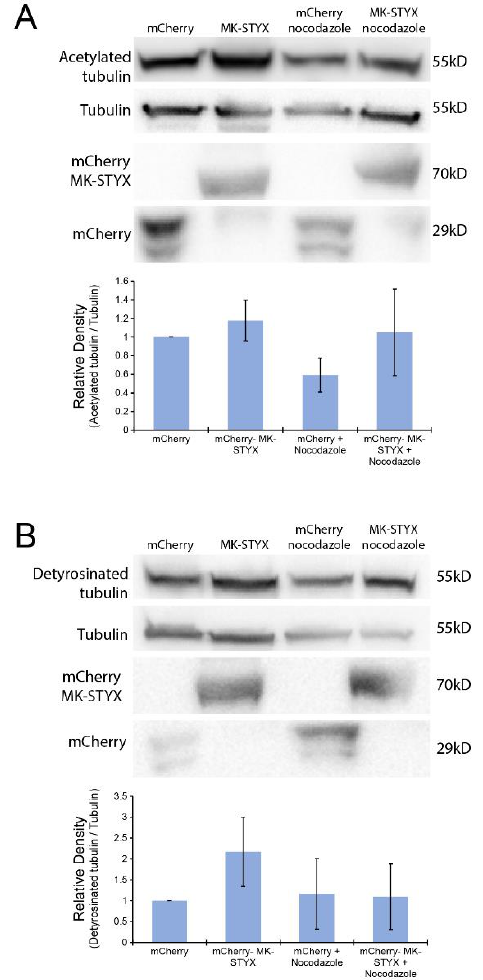
Figure 5. MK-STYX increases acetylated and detyrosinated tubulin. Cells were transfected with expression plasmids for mCherry or mCherry-MK-STYX. Twenty-four hours post-transfection, cells treated with nocodazole or not were lysed and analyzed by immunoblotting. We examined cells expressing mCherry constructs by fluorescence microscopy to confirm transfection. ( A ) Blots were probed with anti-acetylated tubulin and showed that acetylated tubulin (55 kDa) is significantly decreased (paired t -test; p < 0.05) in the presence of nocodazole in control cells (mCherry-expressing) relative to cells expressing mCherry-MK-STYX. Cells overexpressing MK-STYX sustain acetylated tubulin in the presence of nocodazole. The blots were stripped and probed for tubulin as the loading control; they were also stripped and probed with anti-mCherry to confirm expression of mCherry (27 kDa) and mCherry-MK-STYX (67 kDa). ( B ) Lysates were also analyzed for detyrosinated tubulin (55 kDa) by detection with anti-detyrosinated tubulin. A significant increase (paired t -test; p < 0.05) in detyrosinated tubulin was observed in mCherry-MK-STYX-expressing cells in the absence of nocodazole, whereas detyrosination was decreased in cells expressing mCherry-MK-STYX in the presence of nocodazole. Blots were stripped and probed with anti-tubulin antibody for a loading control, then stripped a second time and probed with anti-mCherry antibody to confirm transfection. The error bars are ± SEM; three biologically independent replicate experiments were performed.